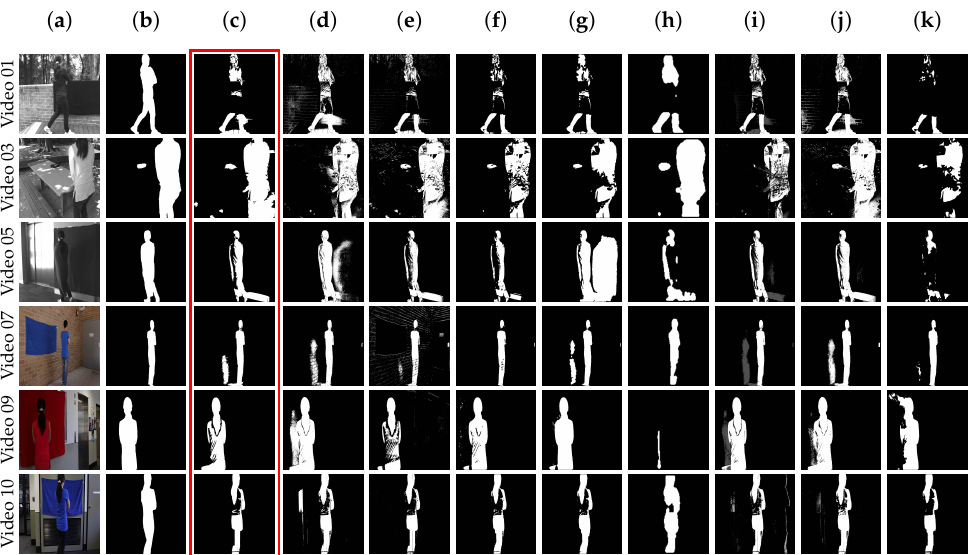
Figure 5. Visual quality comparison on six video sequences of camouflaged moving foreground detection in CAMO-UOW dataset. The columns include ( a ) input frame, ( b ) corresponding groundtruth foreground, ( c ) TensorMoG, ( d ) GMM—Stauffer & Grimson, ( e ) GMM—Zivkovic, ( f ) LOBSTER, ( g ) SuBSENSE, ( h ) SJN-Multiclue, ( i ) IMBS, ( j ) PBAS, ( k ) PAWCS.